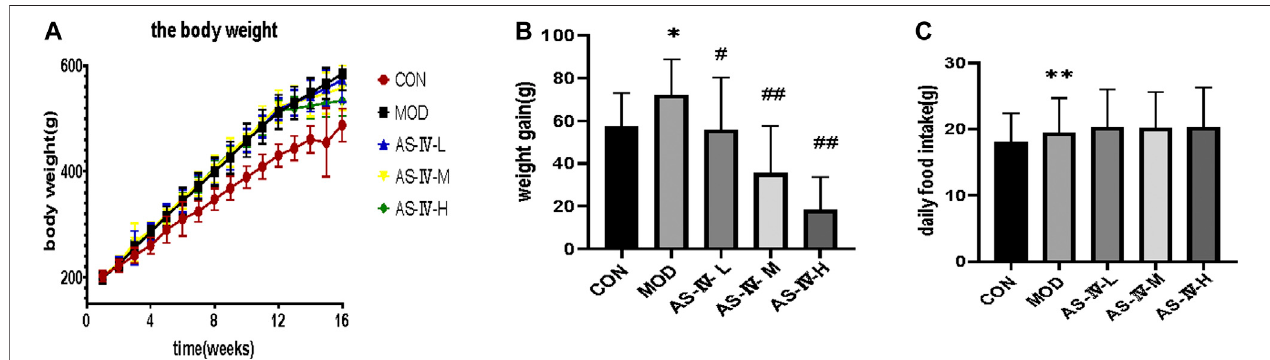
FIGURE2| Bodyweightanddailyfoodintakeofrats. (A) Thebodyweightofrats. (B) Thebodyweightgainafter12 weeks. (C) Theaveragedailyfoodintakeofrats in different groups. Data present the mean ± SD. Comparisons between two groups use t -tests, and data comparison among multiple groups use one-way ANOVA. * p < 0.05 and ** p < 0.01 compared with the control group; # p < 0.05 and ## p < 0.01 compared with the model group. CON, control group; MOD, model group; AS-IV-L, astragaloside IV low-dose group; AS-IV-M, astragaloside IV middle-dose group; AS-IV-H, astragaloside IV high-dose group.